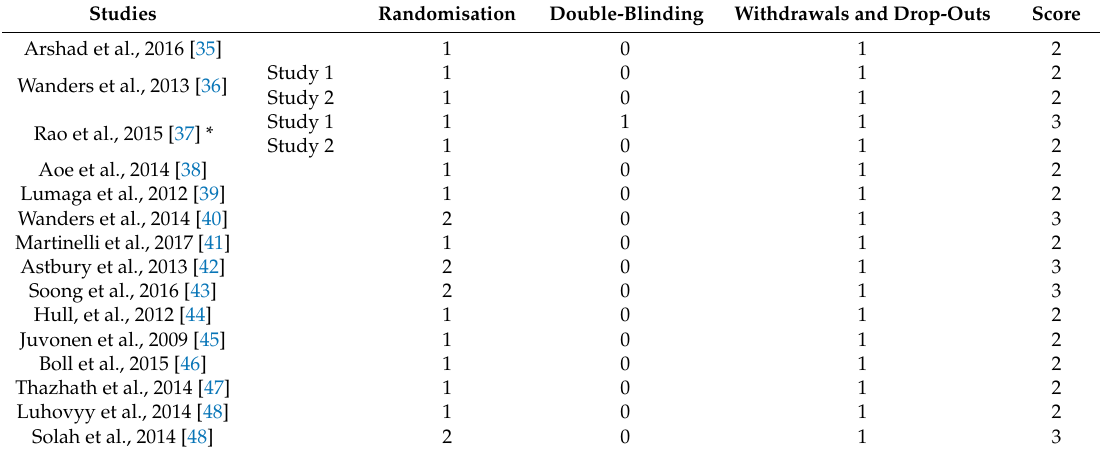
Table 2. Jadad scores of RCTs ( n =